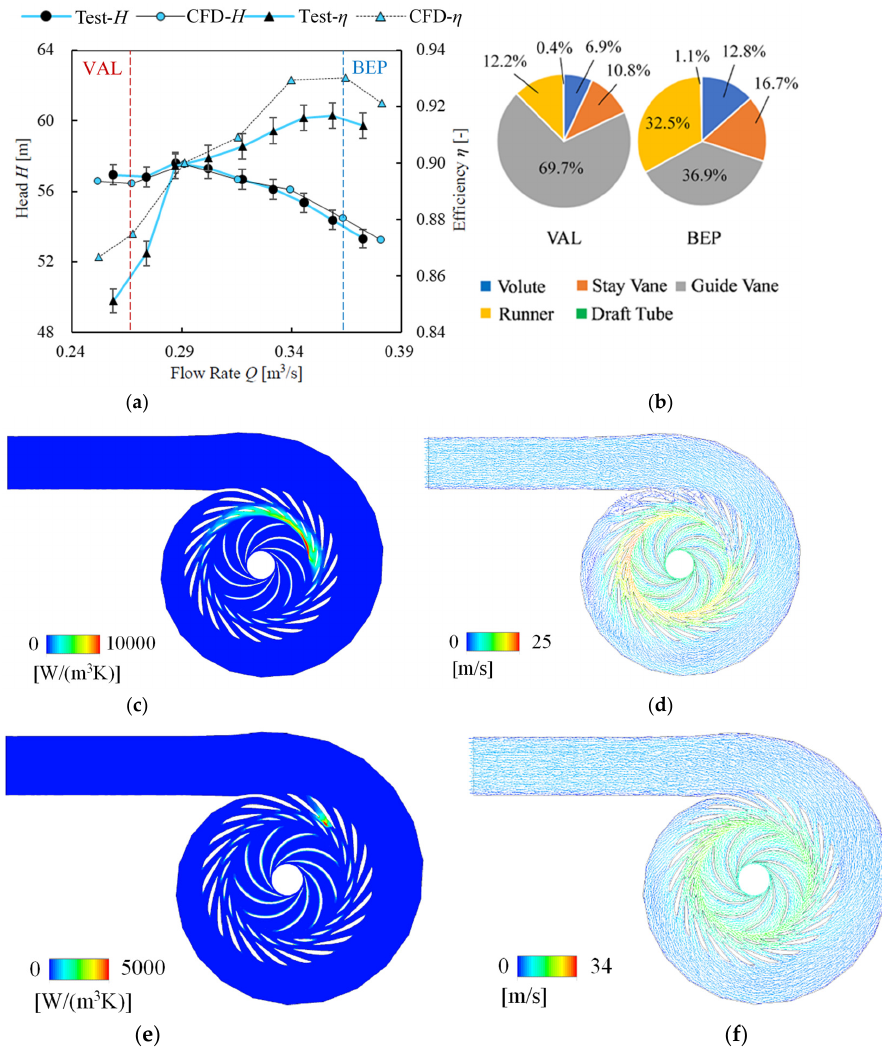
Figure 8. Performance curve and flow pattern at 14° attack angle. ( a ) Q-H and Q- η curve; ( b ) proportion of flow energy loss; ( c ) VAL S pro ; ( d ) VAL v ; ( e ) BEP S pro ; ( f ) BEP v ; VAL: local valley of Q-H curve; BEP: best efficiency point.